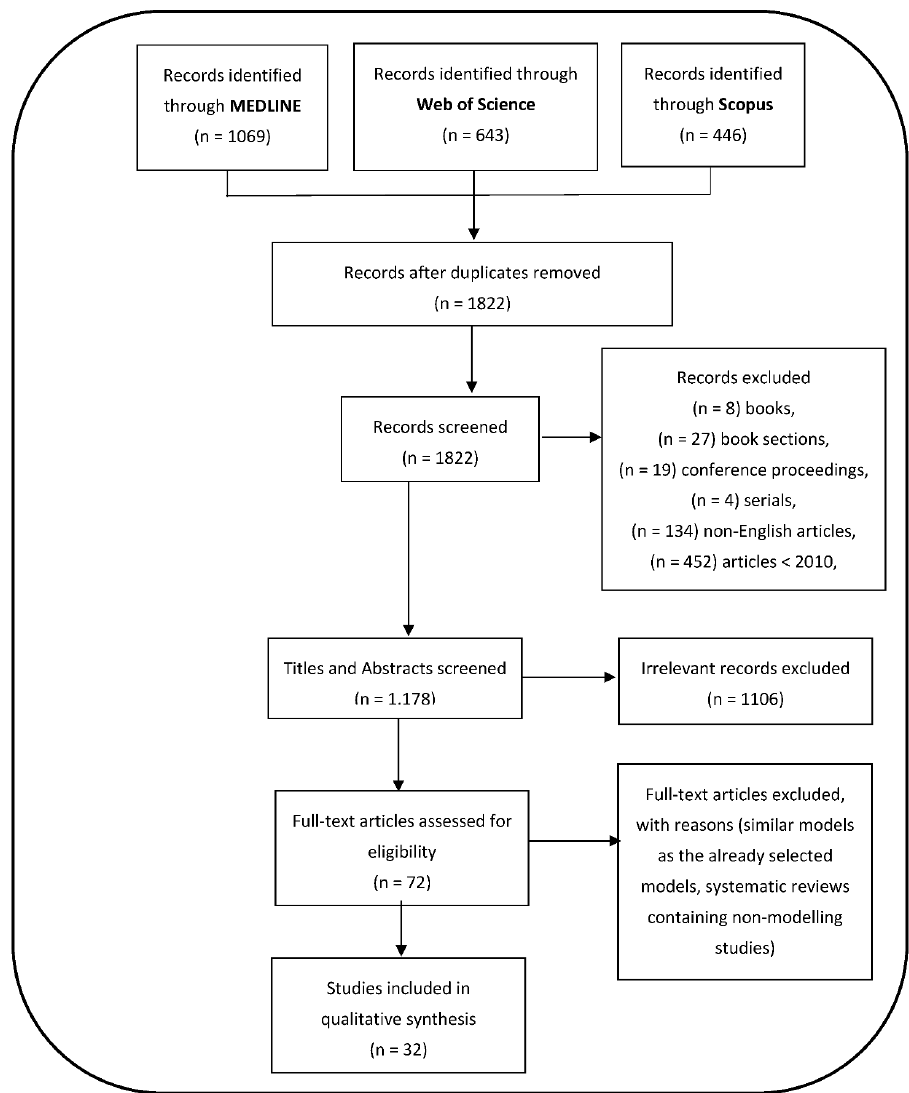
Figure 2. PRISMA flowchart for article selection process.